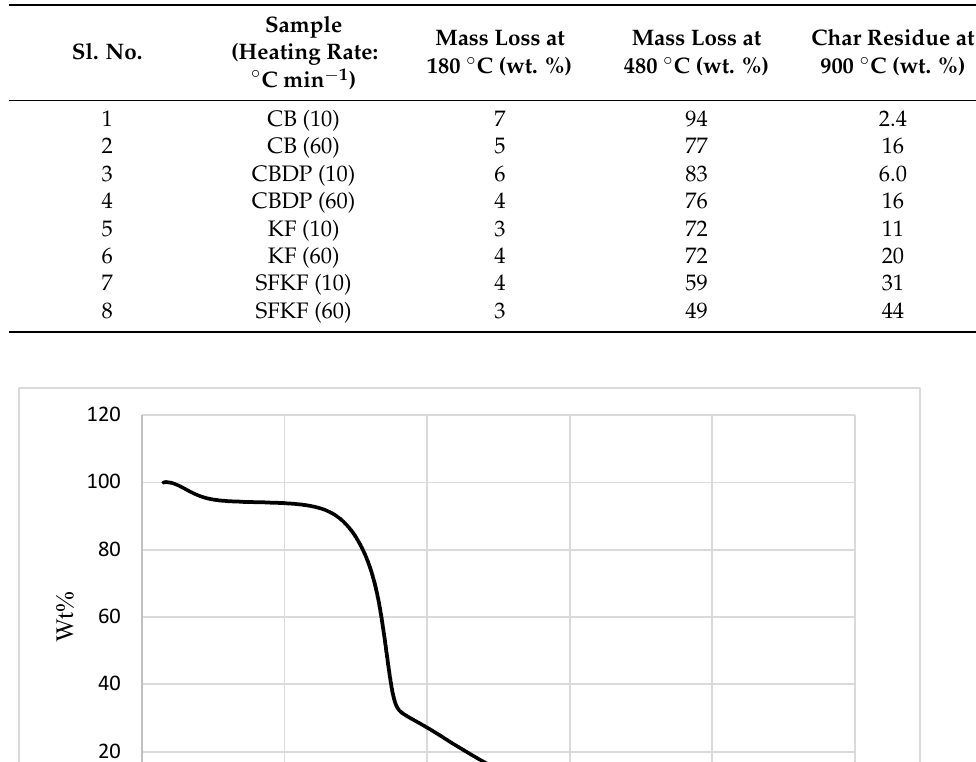
Table 3. Mass losses and the amount of residue obtained during the TGA tests.